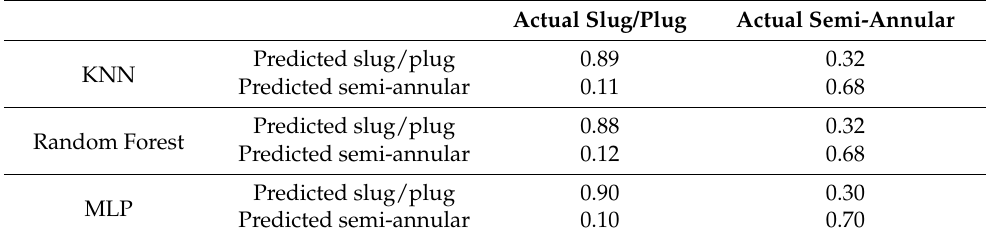
Table 9. Confusion matrix results for ethanol.